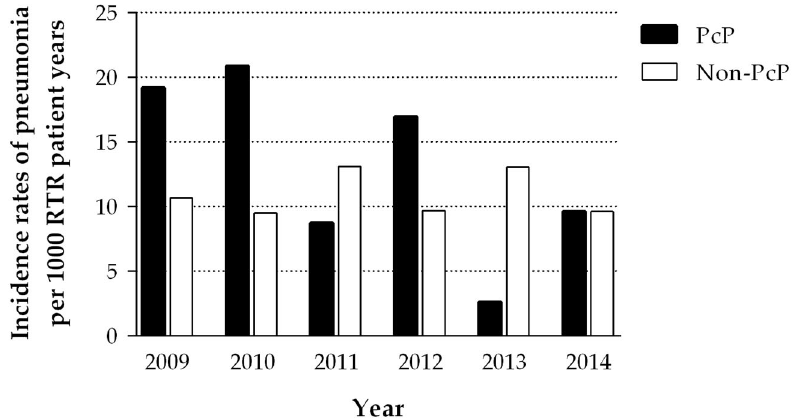
Figure 1. Incidence rates of pneumonia in renal transplant recipients (RTRs) at our center per 1000 patient years; black: Pneumocystis jirovecii pneumonia (PcP); white: pneumonia with other presumably bacterial pathogens (non-PcP). PcP shows an alternating incidence with particularly high incidence rates per 1000 patient years in 2009, 2010 and 2012, whereas the non-PcP cohort shows a relatively constant incidence.